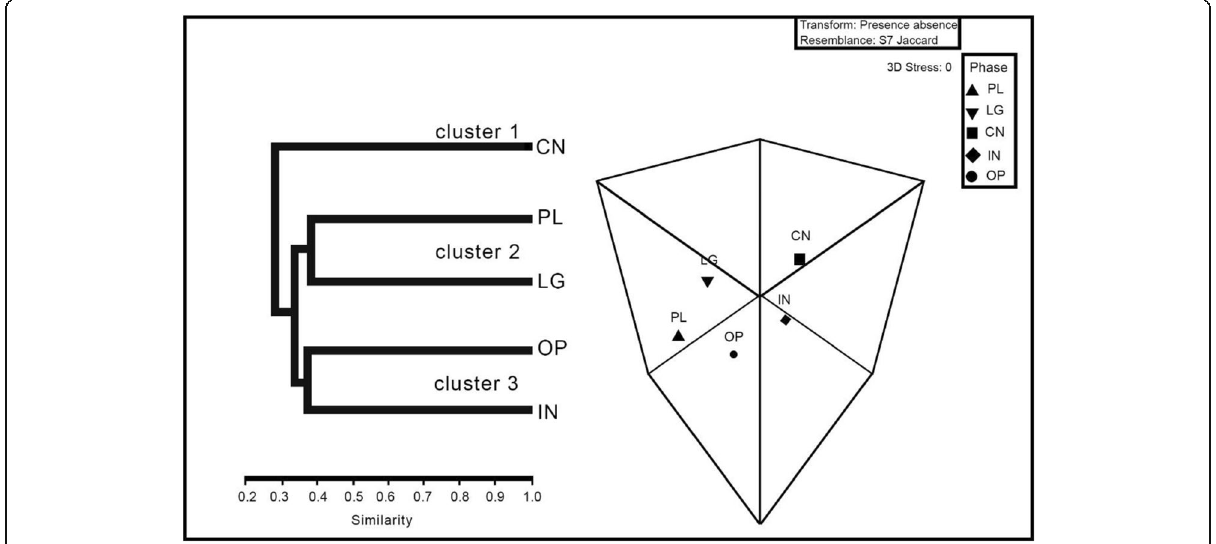
Fig. 3 Cluster analysis and three-dimensional non-metric multidimensional scaling (3D-NMDS) plot of Jaccard similarity matrixes showing the distribution of bird communities according to phases in Puah Lake Catchment, Hulu Terengganu, Peninsular Malaysia. The good quality of the